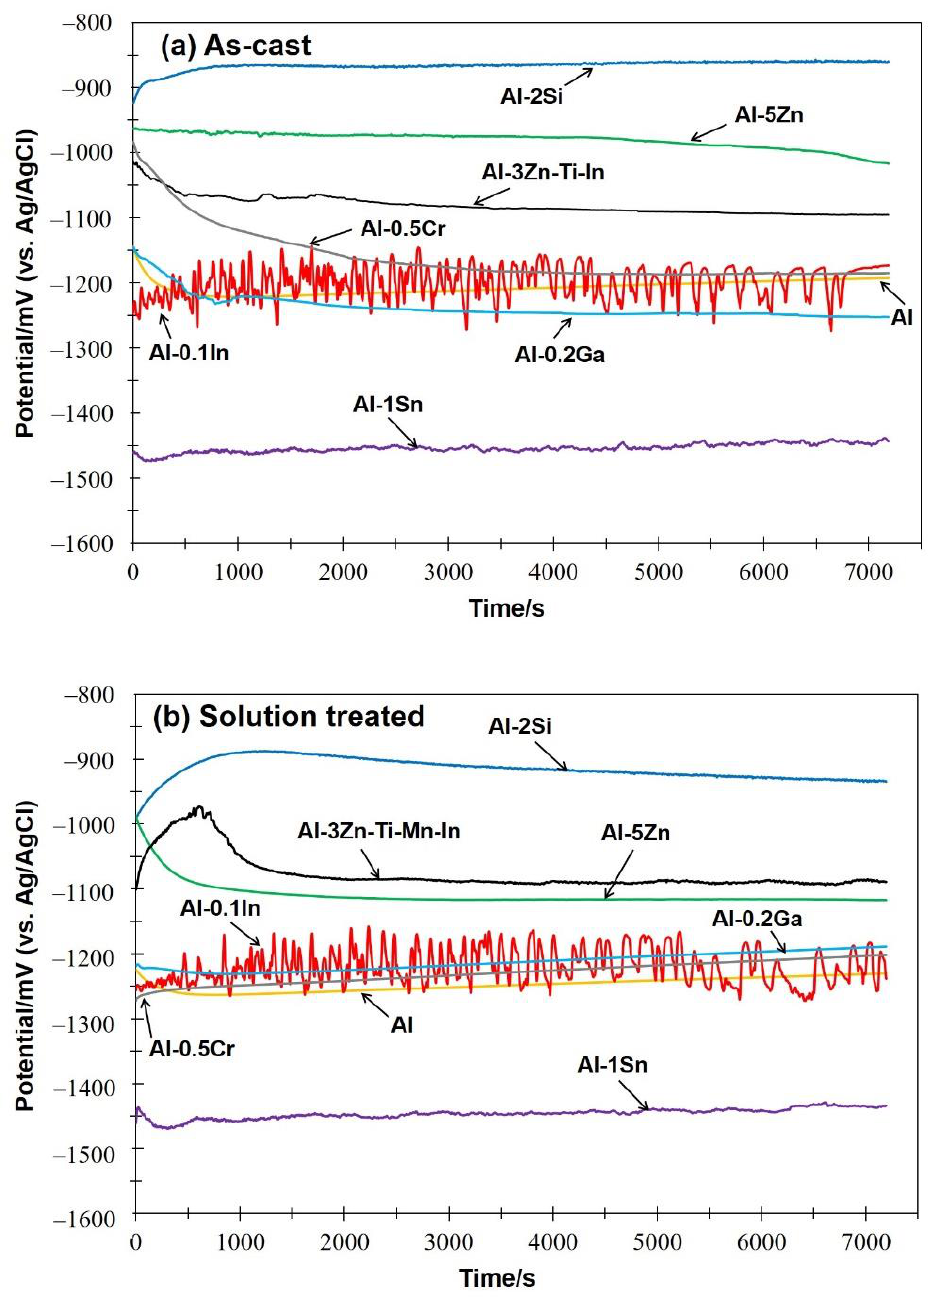
Figure 5. Open circuit potential (OCP) of as-cast ( a ) and solution-treated ( b ) Al-based alloys. Table 4. Corrosion properties of the Al-based alloys in as-cast and solution-treated conditions.